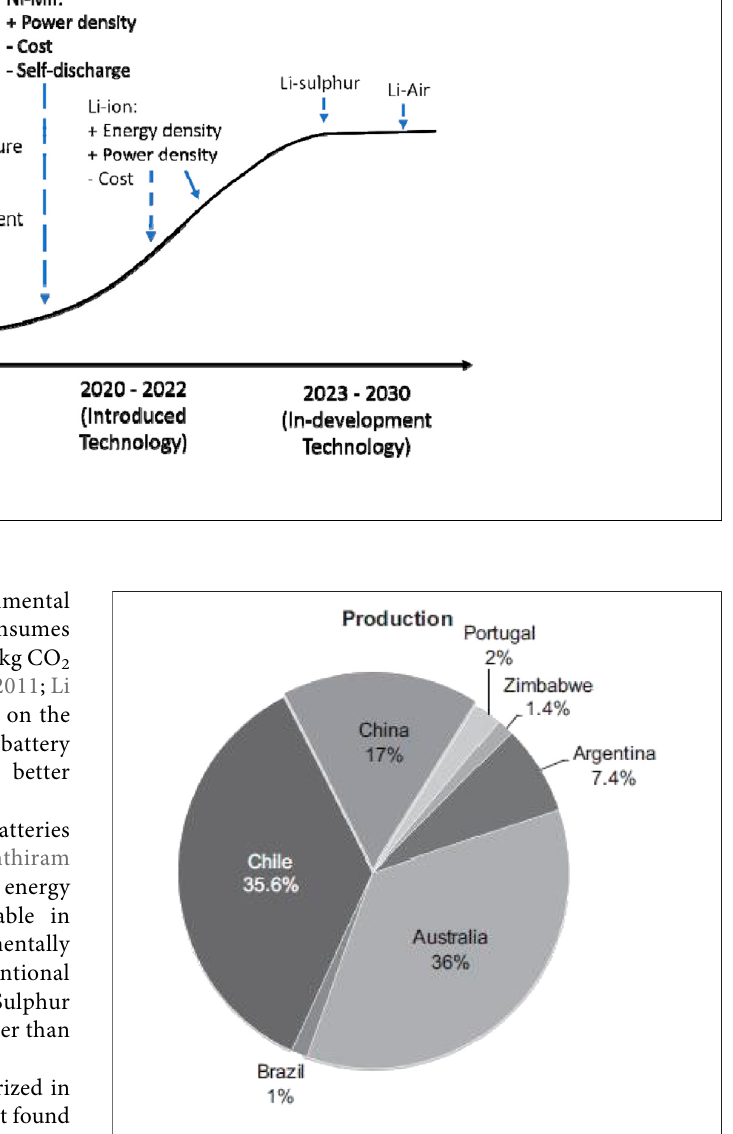
FIGURE14| Distributionoflithium reserves in2011 (Zhang